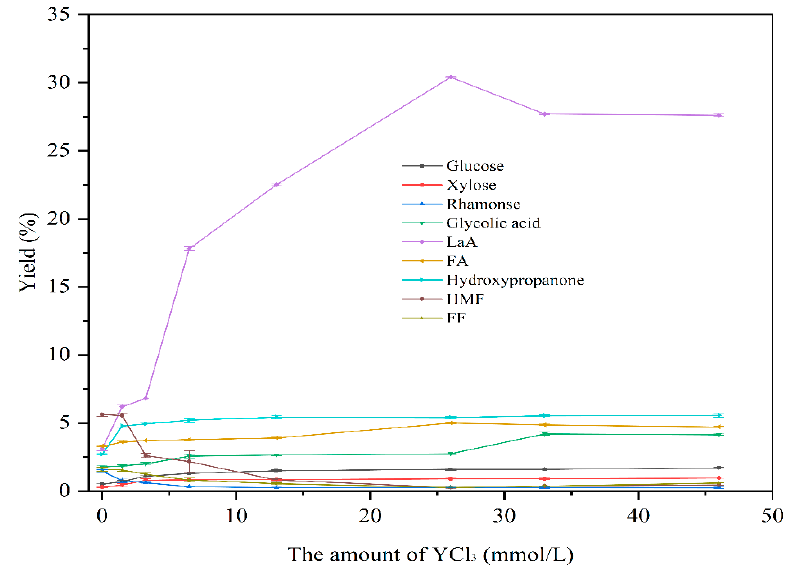
Figure 2. Yields of small molecular products from hydrothermal conversion of U. prolifera with dif- ferent amount of YCl 3 . Reaction conditions: 1.0 g of U. prolifera , 100 mL water, 200 °C, 2 MPa N 2 , 1 h.